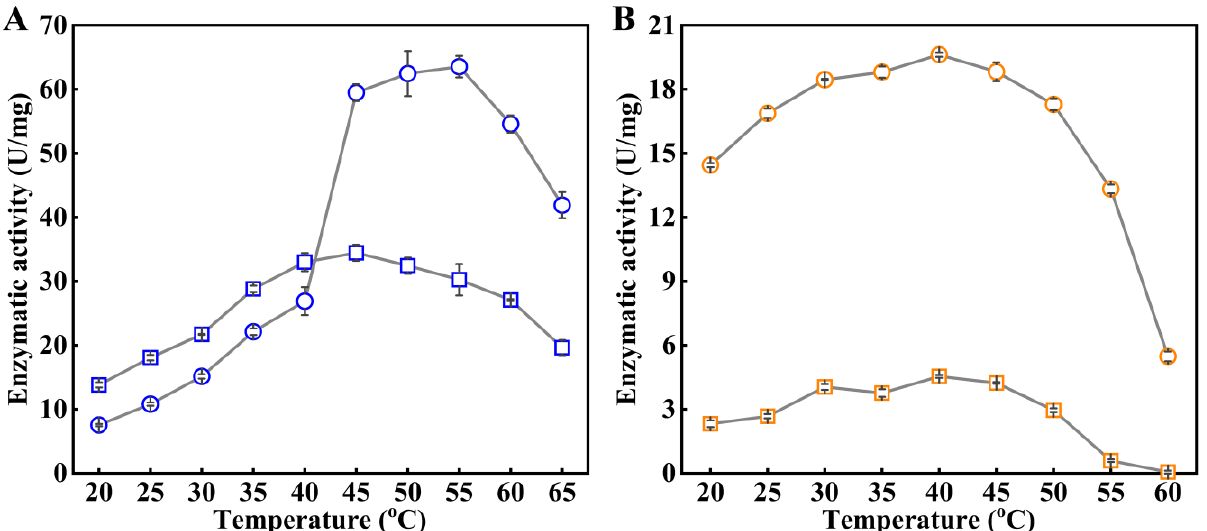
Figure 7. Effects of 0.1% ( w / v ) DOC on enzyme activity of arylesterase LggEst wild type and the deleted mutant at different temperatures. ( A ) Effects of 0.1% ( w / v ) DOC on enzyme activity of LggEst wild type at 20 – 65 °C. The enzymatic activities without and with 0.1% ( w / v ) DOC are shown in blue square and circle, respectively. ( B ) Effects of 0.1% ( w / v ) DOC on enzyme activity of arylesterase LggEst deleted mutant at 20 – 60 °C. The enzymatic activities without and with 0.1% ( w / v ) DOC are shown in orange square and circle, respectively. Enzymatic activity by adding the corresponding volume of 50 mM NaH 2 PO 4 -Na 2 HPO 4 buffer (pH 7.5) was taken as the control. All reactions were performed in triplicate, and error bars represent the standard deviations of mean.